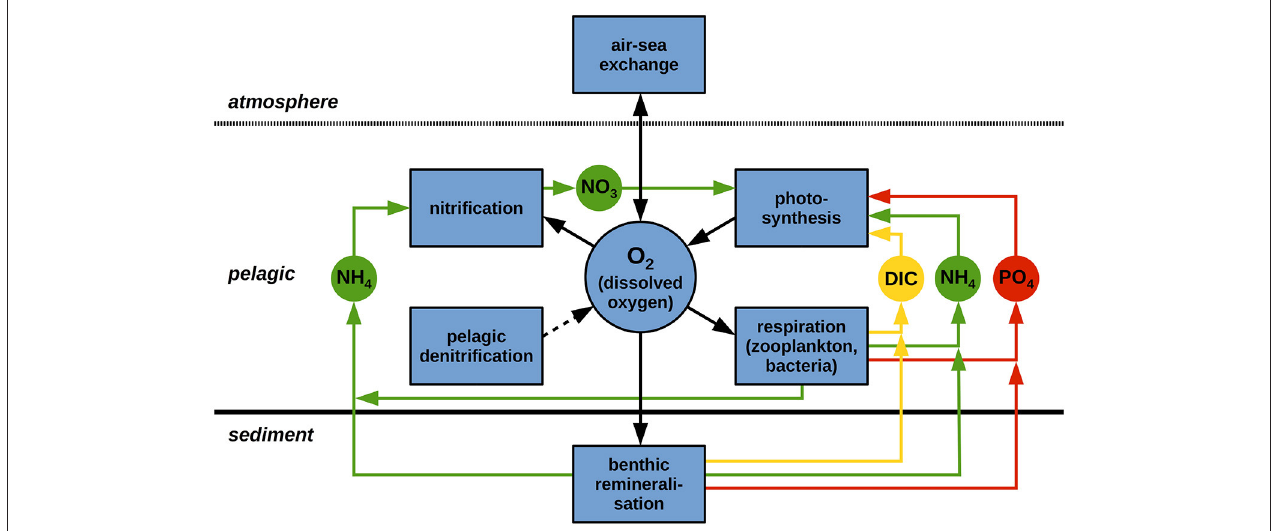
FIGURE 1 | Schematic view of the O 2 cycle as implemented to ECOHAM (black framed boxes and black arrows), including the links to the C, N, and P cycles (yellow, green and red, respectively). Linking state variables are: dissolved inorganic C (DIC), NH + 4 , NO − 3 , and PO 3 − 4 . Adapted from Müller (2008).